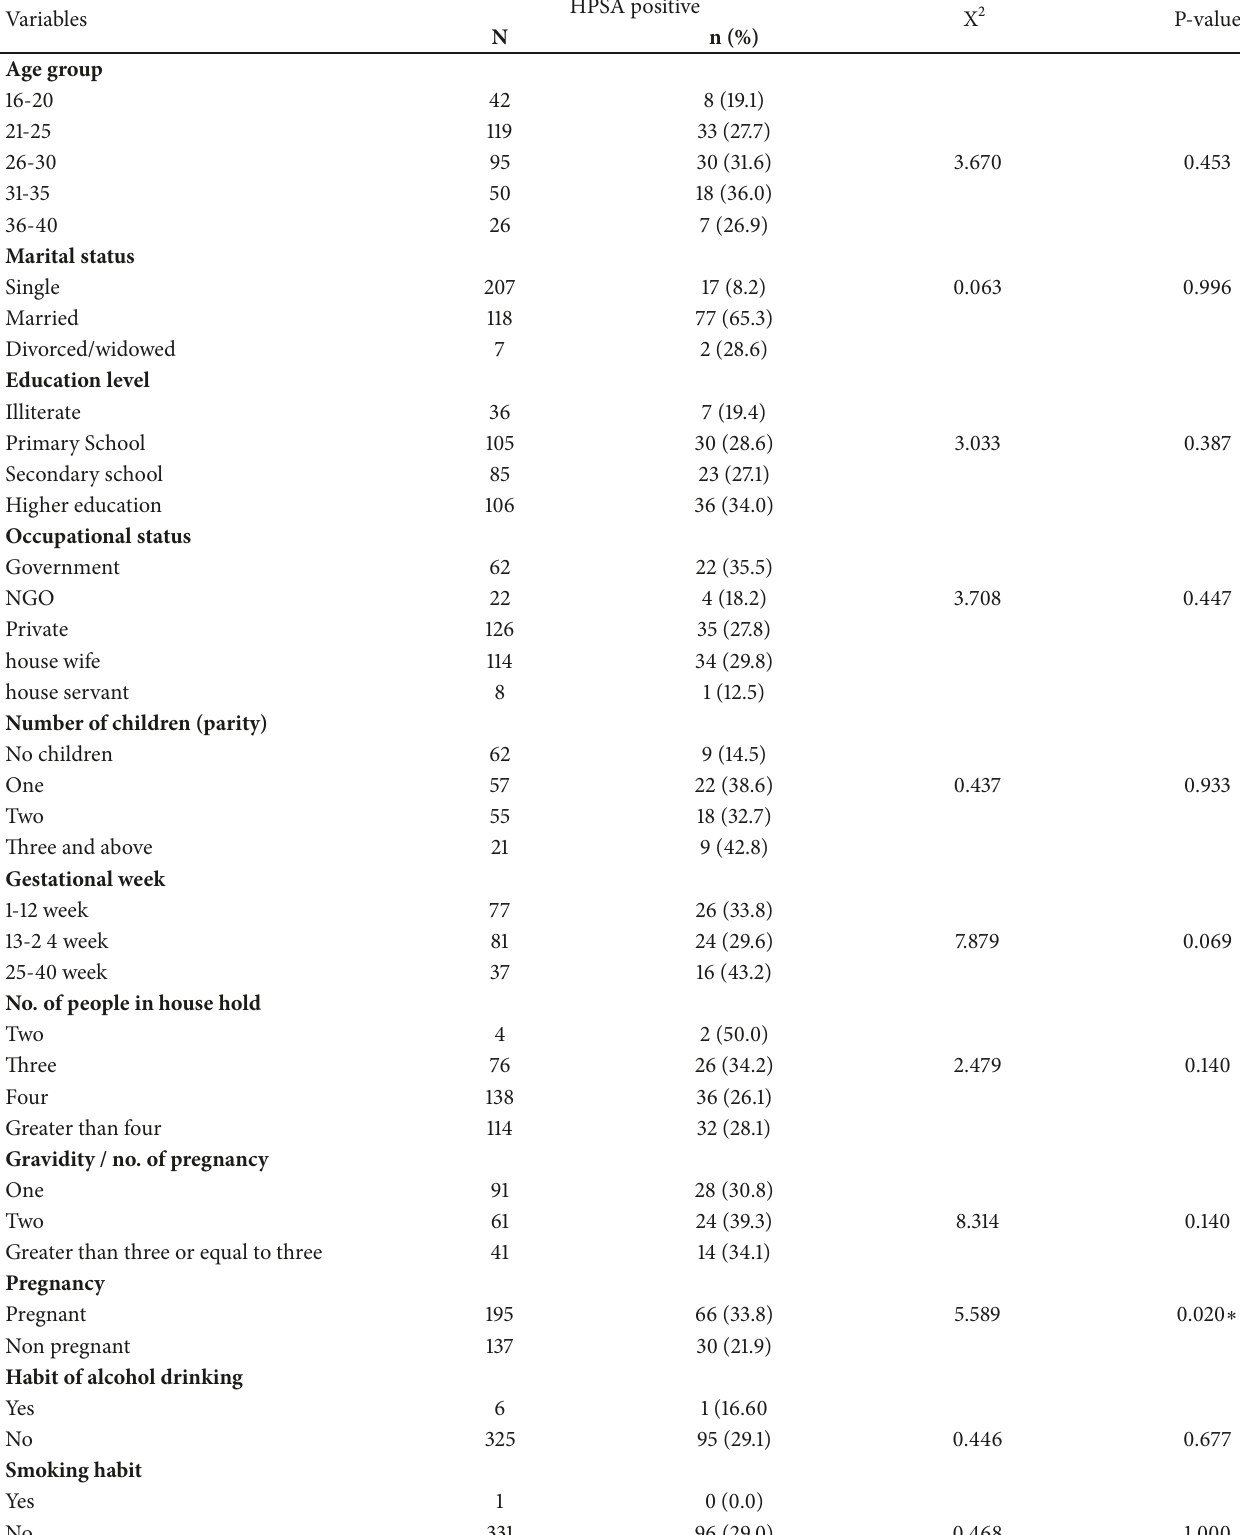
Table 2: Univariate analysis showing association of H. pylori infection with some associated risk factors among study participated in Woreda 9 HC, Addis Ababa, Ethiopia, April to October 2015